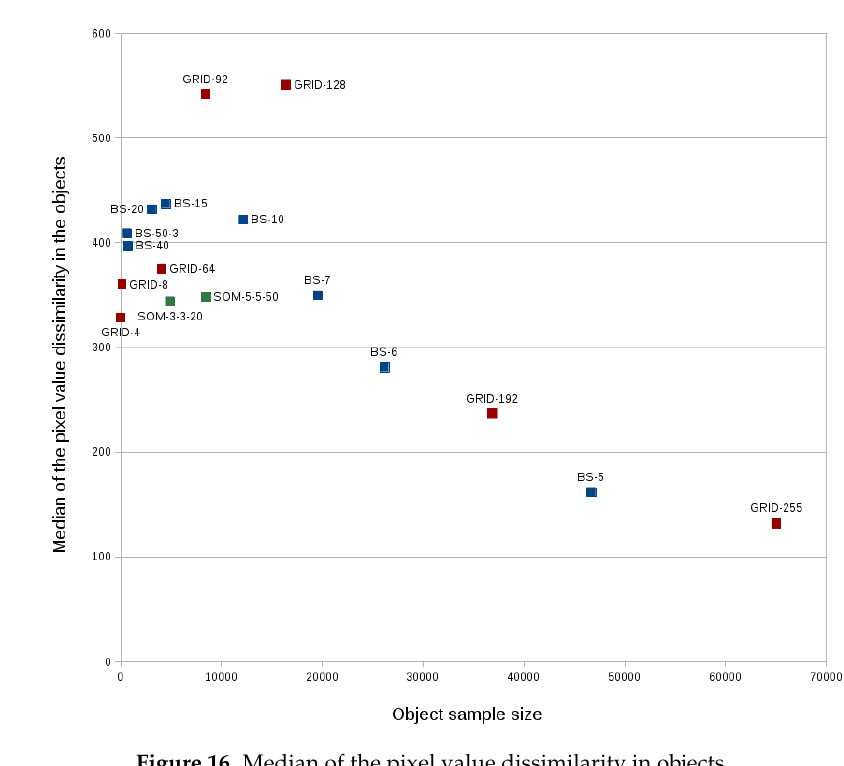
Figure 16. Median of the pixel value dissimilarity in